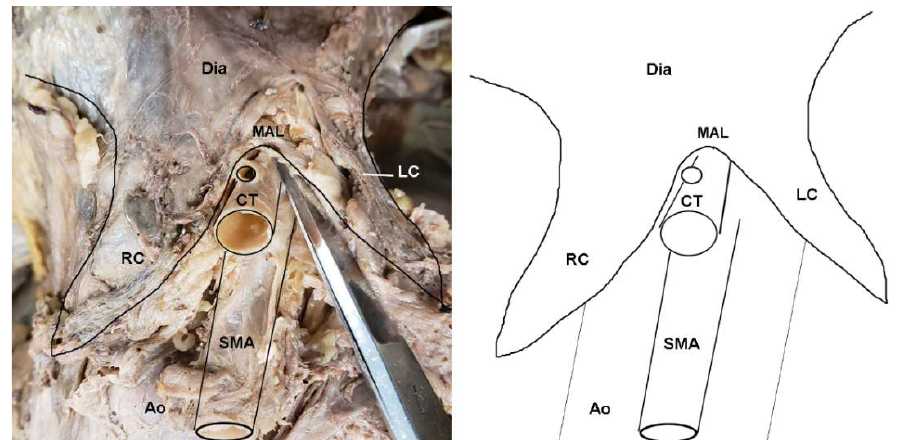
Figure 2. Dissection photo showing compression of the celiac trunk by the median arcuate ligament in a cadaveric subject: ( left ) Photo; ( right ) illustration. Abbreviations are as follows: Ao = aorta; CT = celiac trunk; Dia = diaphragm; LC = left crus of diaphragm; MAL = median arcuate ligament; RC = right crus of diaphragm; SMA = superior mesenteric artery. Table 1. Cadaveric data on anatomical variables measured broken down by sex and MAL/CT overlap status.